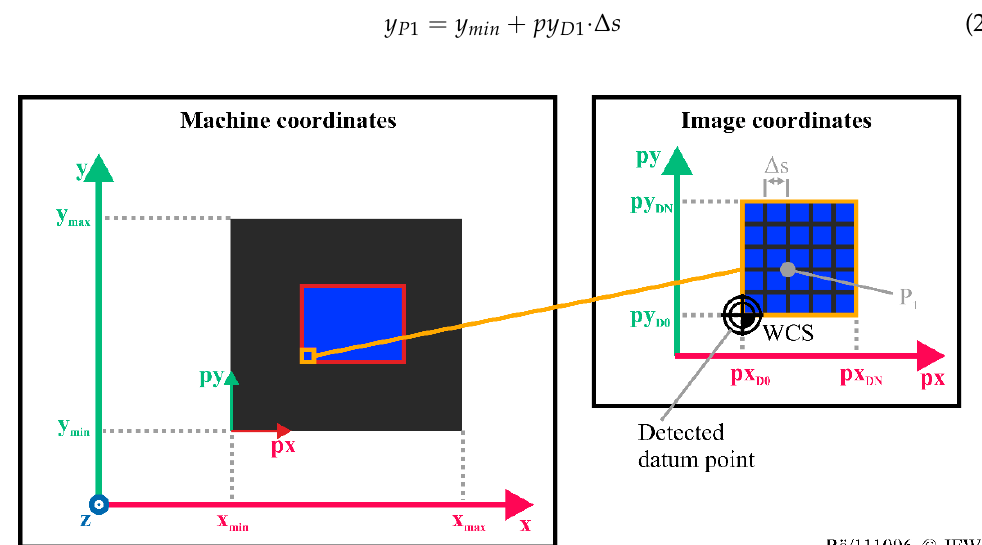
Figure 10. Visualization of the coordinate transformation.